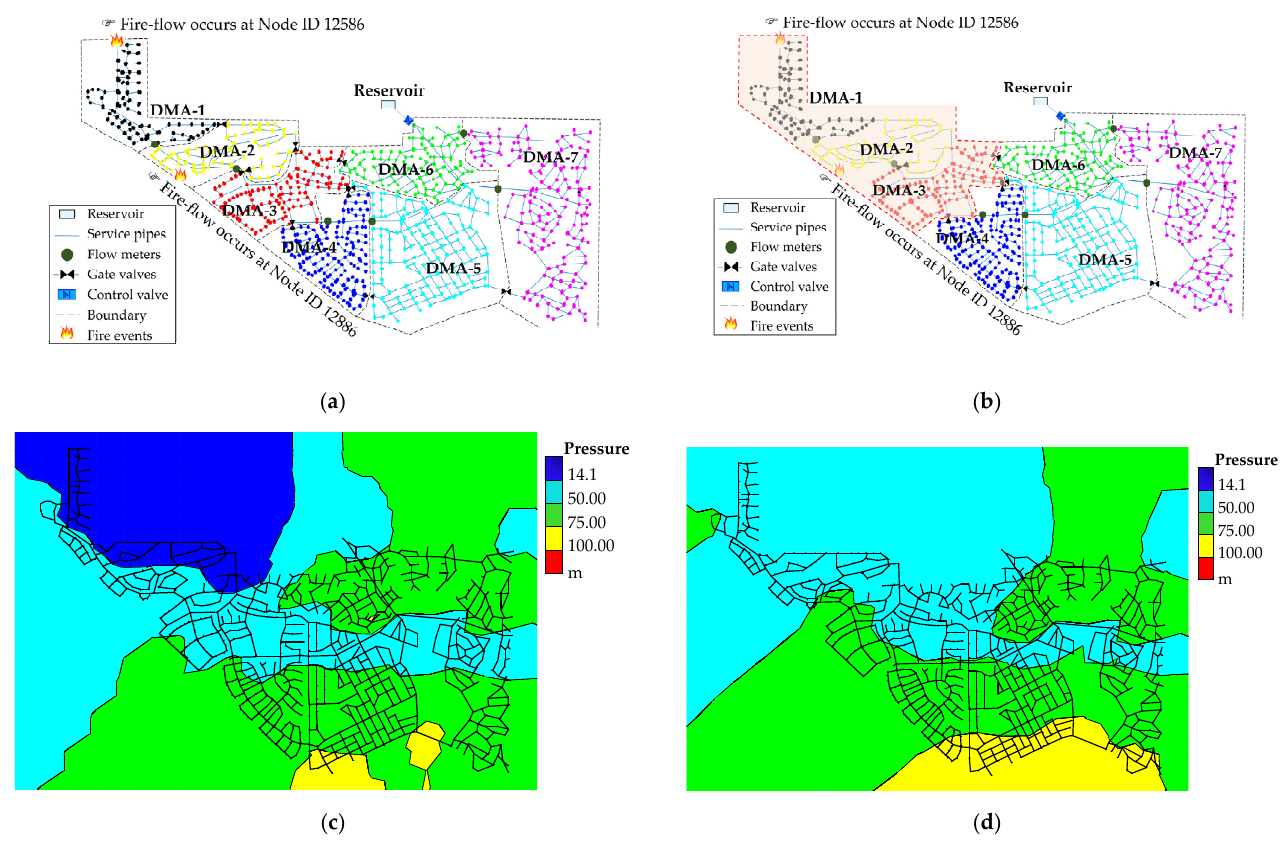
Figure 12. Simulation of fire-flow scenario: ( a ) original 7 DMAs layout with fire events; ( b ) network adaptation by merging DMAs 1, 2, and 3 into one larger DMA; ( c ) contour plot of pressure for original 7 DMAs layout under fire events; ( d ) contour plot of pressure after DMAs merging by opening the gate valves under fire events.